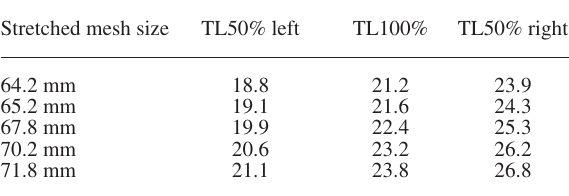
Table 8 . – Total length (TL; cm) of soles with 50% retention prob- ability on the left side of the log-normal selection curve, 100% and 50% on the right side of the log-normal selection curve.